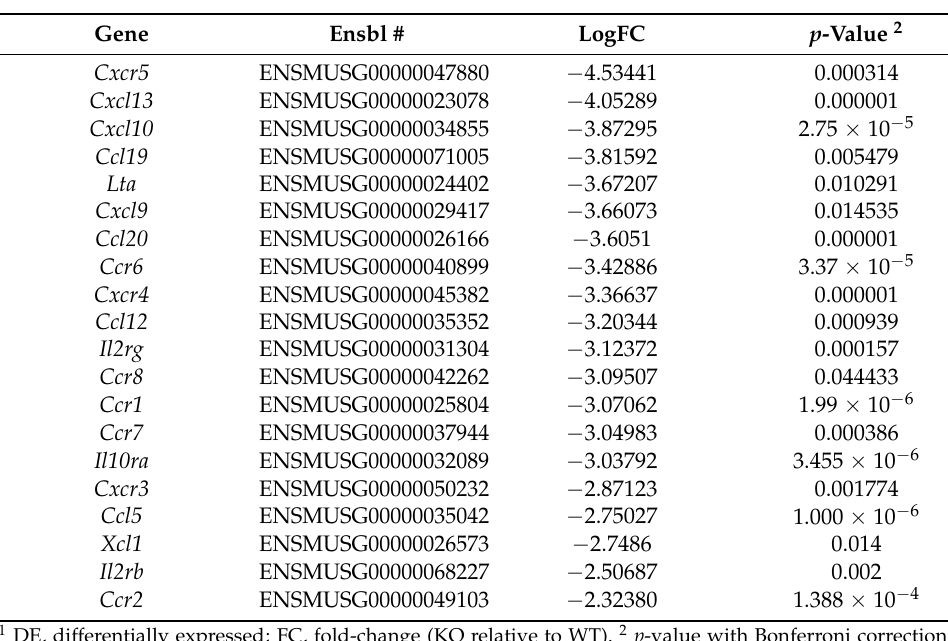
Table 5. Top 20 DE genes in viral protein interactions with cytokine and cytokine receptor pathway 1 .